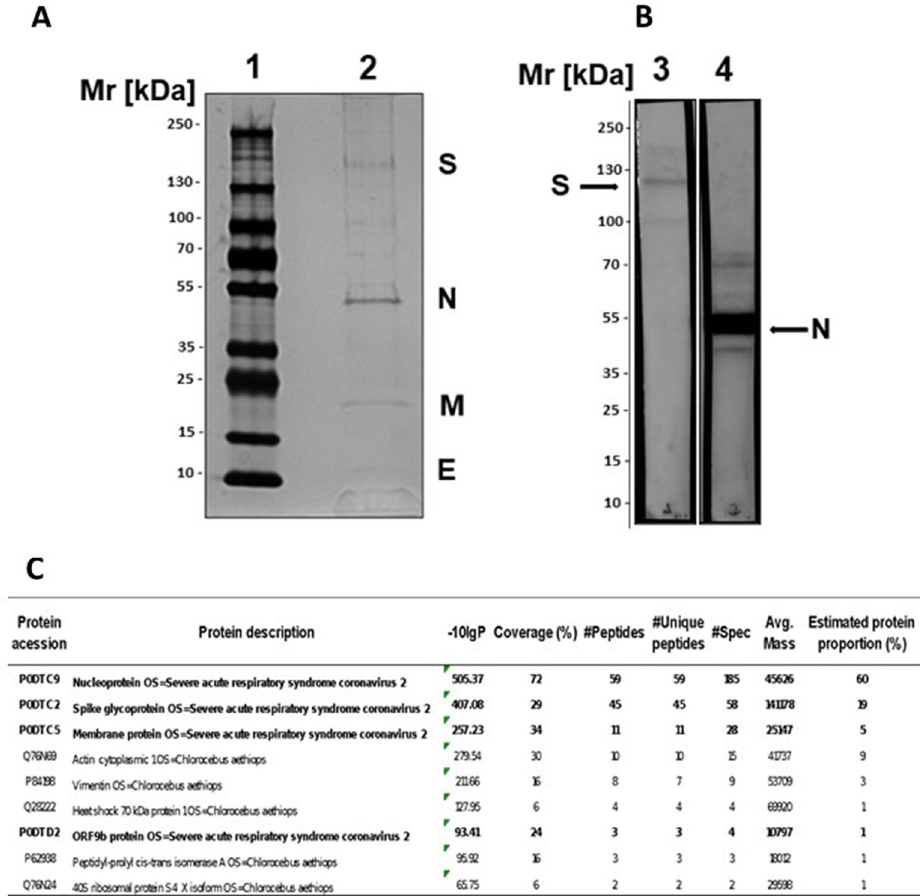
Figure 1. Analysis of the purified and inactivated SARS-CoV-2. ( A ) SDS–PAGE: 4–15% gradient SDS–PAGE gel under nonreducing conditions and silver staining. (1) LMW marker—10 to 250 kDa; (2) Purified and inactivated SARS-CoV-2. ( B ) Western blot: samples of the virus, which were separated on 4–15% gradient SDS-PAGE gels, were blotted onto nitrocellulose membranes and incubated with monoclonal antibodies against the SARS-CoV-2 S protein (Lane 3) or anti-SARS-CoV-2N protein (Lane 4). The membranes were incubated with specific peroxidase-conjugated anti-rabbit IgG (1:5000), and the reactions were revealed using SuperSignal West Pico chemiluminescent substrate. ( C ) Protein identification through tandem mass spectrometry analysis (LC–MS/MS) of the inactivated SARS-CoV-2 purified antigen. Only proteins with at least 1 unique peptide, a score − log10P > 20 and a false discovery rate < 1% were accepted for identification and are depicted in the Table. The proportion of proteins was estimated based on the mass spectra counts of each identified protein. ( A ) and ( B ) were cropped, the original results are presented in Fig. S7. ( B ) is composed of two panels, representing two membrane strips processed separately, and a third strip containing a molecular weight marker was used do estimate the molecular sizes of bands (Fig.